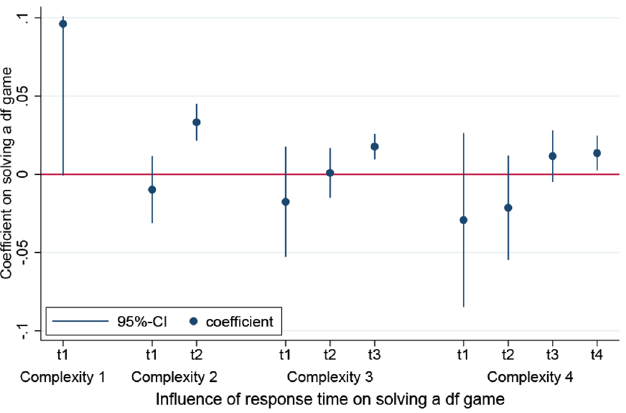
Fig 4. Effect of response time on solving a df